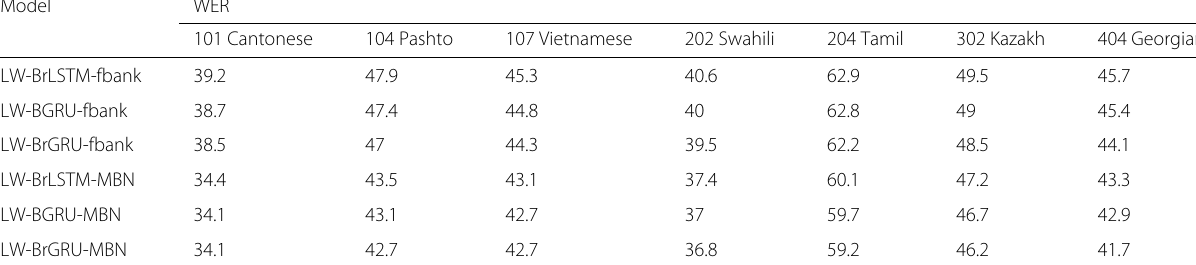
Table 12 WER (%) of the LW-BrLSTMs, LW-BGRUs and LW-BrGRUs for all languages Model